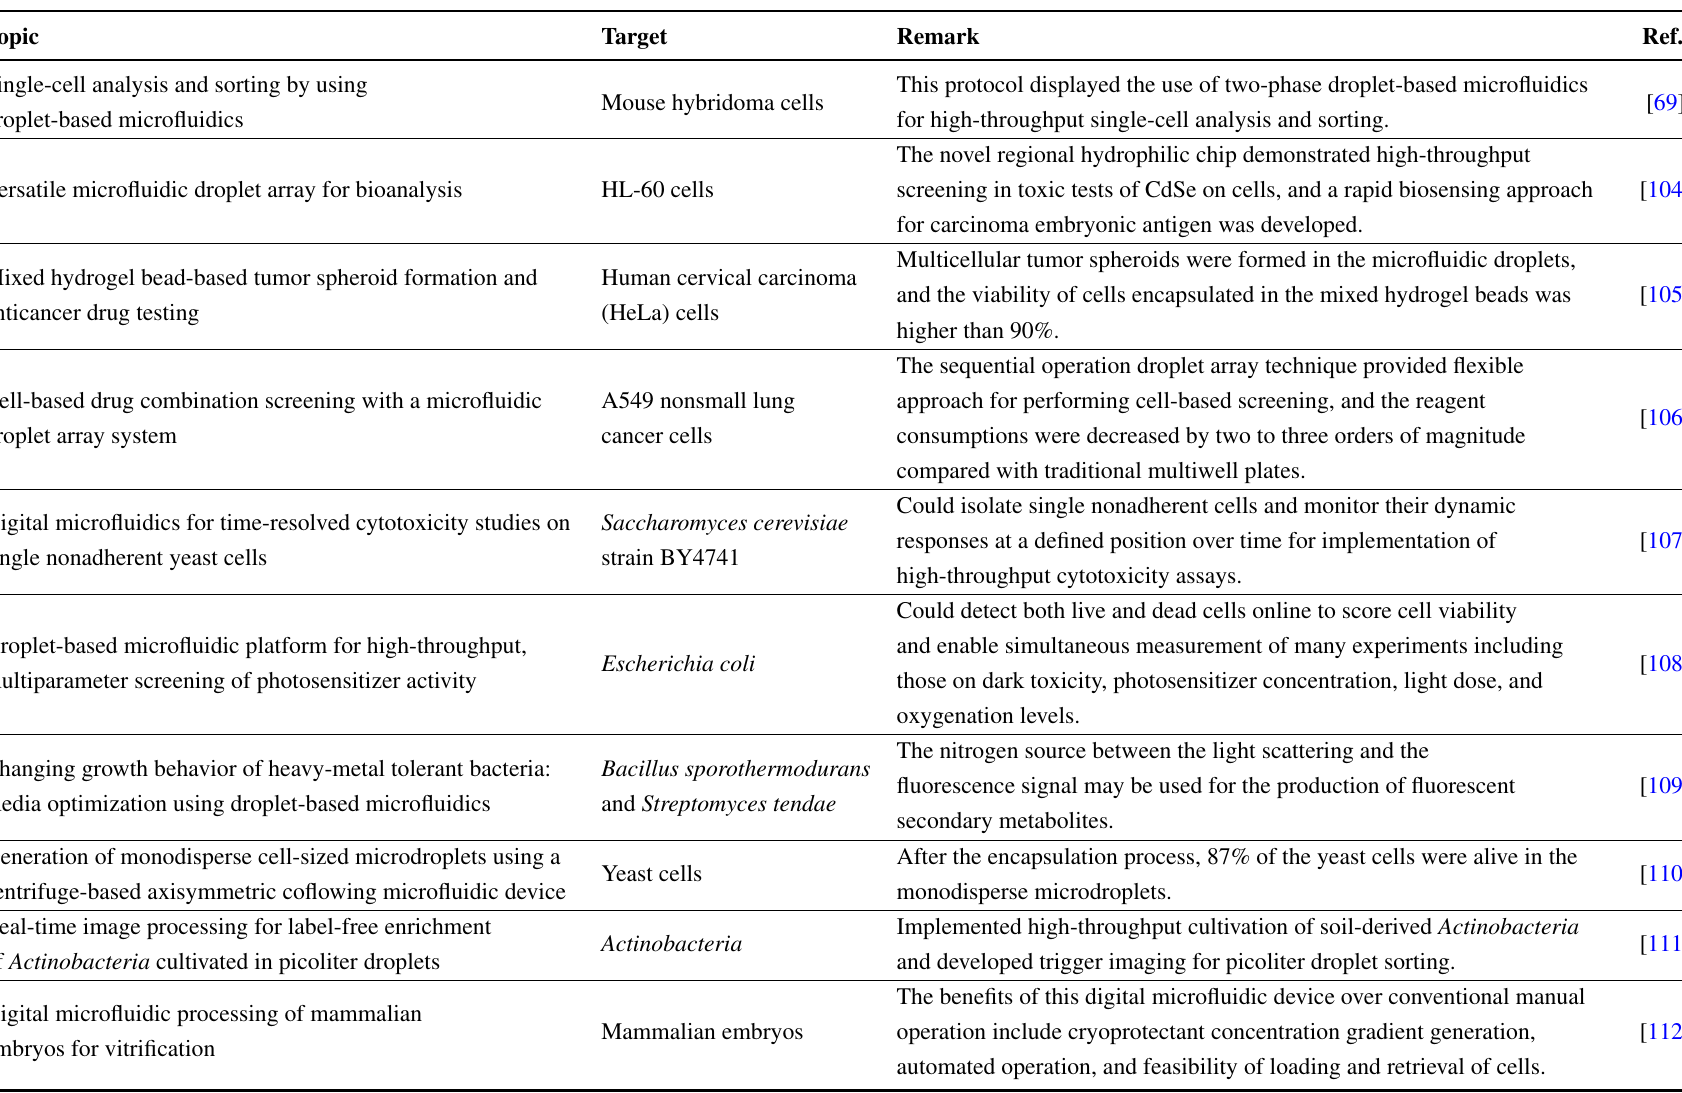
Table 5. Recent applications of droplet microfluidics in cell